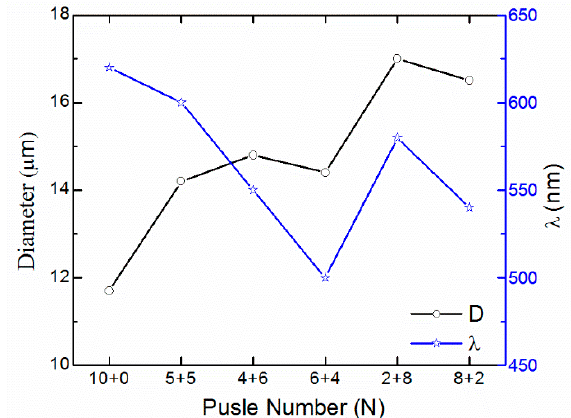
Figure 5. Dimensions and periods of a multiple-shot ablated region with subwavelength ripples at different femtosecond pulse irradiation modes.